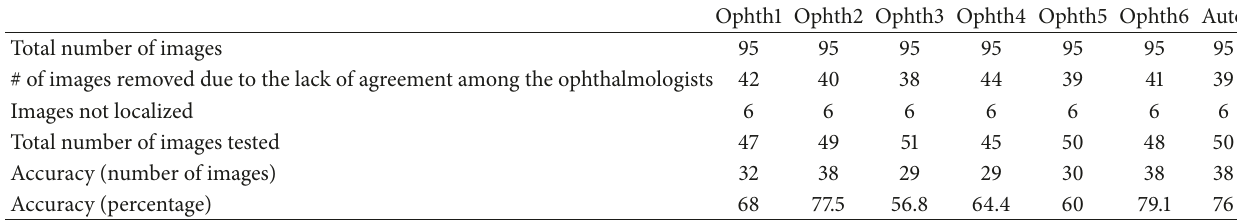
Table 8: The VCDR results for Magrabi images set.